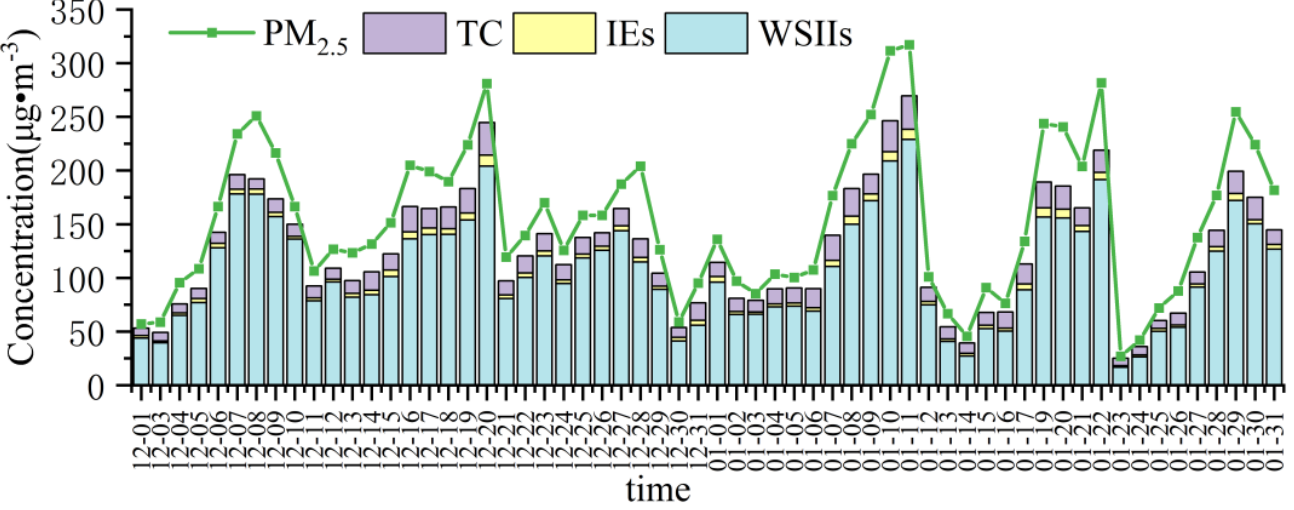
Figure 2. Diurnal variations of mass concentrations of PM 2.5 and chemical components in Shihezi urban area in winter.